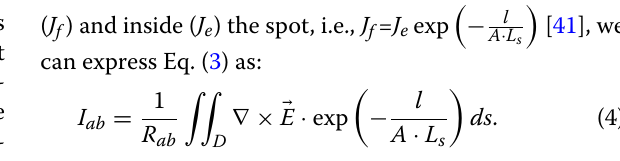
Here, l is the distance between the edge of light spot and the connection of the two contacts, L s is the dif- fusion length of electrons, and A is a constant. Using Eqs. (2) and (4) to fit the experimentally measured PISHE current, we can obtain the spin transverse force f 0 and the diffusion length A · L s . The fitting result is shown in Fig. 1c by a solid line. One can see that the experimental data is well-fitted by the model. In the fitting, the fol- lowing experimentally measured parameters are adopted, σ = 0.2 mm, L = 4 mm, r = 0.7 mm, and R = 15.5 k (cid:7) . 0 ab The spin transverse force f 0 / q of electrons is fitted to be 6.8 × 10 − 6 N · m/C at 300 K, A · L s is fitted to be 2.8 × 10 − 4 m, and the radius of the absorption satu- rated area is fitted to be 0.34 mm, which indicates that the absorption saturated intensity of the light I c corre- sponds to about one fifth of the maximum intensity I m , i.e., I c = 1/5 I m .